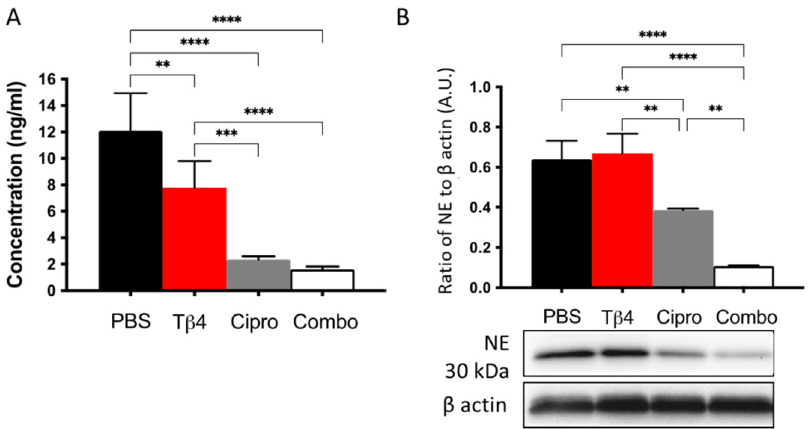
Figure 5. In vivo assessment of NETosis activity following P. aeruginosa -induced corneal infection. Citrullinated histone H3 concentration was detected from corneal lysates at 3 d p.i. by the ELISA ( A ). Data are reported as mean concentration (ng/mL) ± SD of three independent experiments in the PBS control, T β 4-, cipro-, and adjunct-T β 4 groups. Protein levels of NE were measured by Western blot ( B ). Results shown are representative of three independent experiments and normalized to β - actin ± SD. n = 3; ** p < 0.01; *** p < 0.001; and **** p < 0.0001.